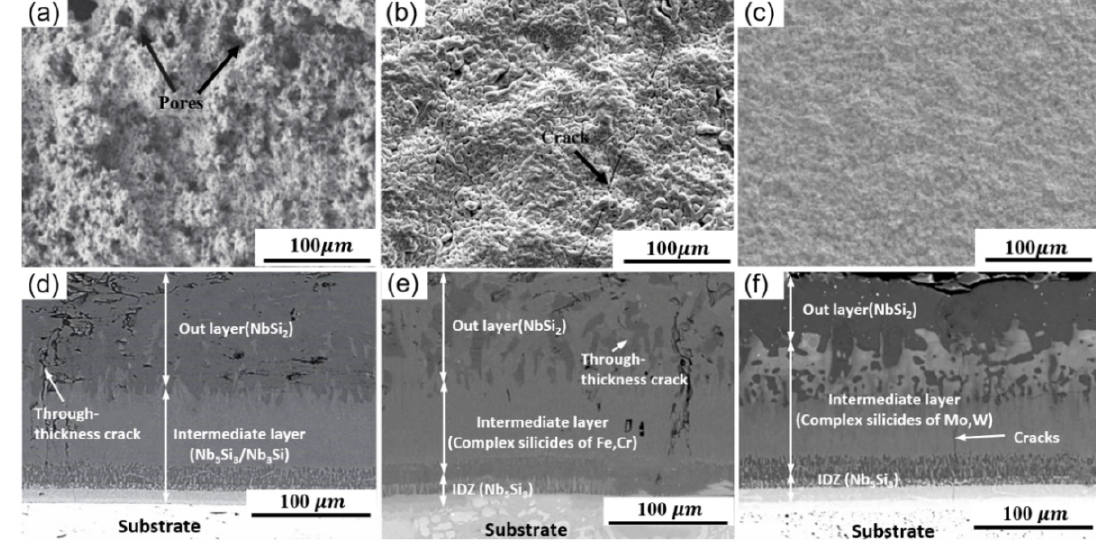
Figure 2. Scanning electron microscope (SEM) images of silicide coatings prepared by SS: ( a , d ) of pure NbSi 2 coating; ( b , e ) NbSi 2 -(Fe, Cr) 3 Si 2 composite coating; ( c , f ) NbSi 2 -(Mo,W)Si 2 composite coating.